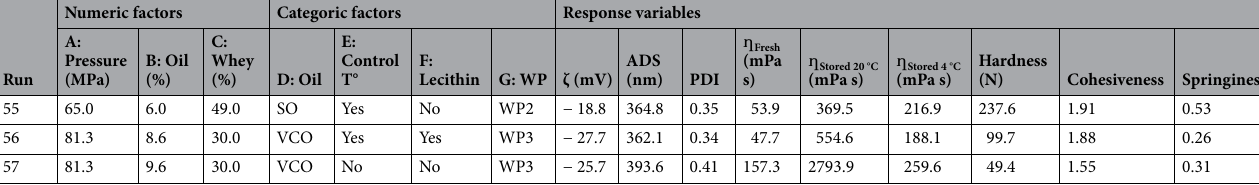
Table 1. Response optimization surface experimental design methodology for preparation of emulsions and adjusted variables to the model: ζ, ADS, PDI, ƞ for fresh and stored emulsions at 20 °C and 4 °C, and hardness, cohesiveness and springiness of